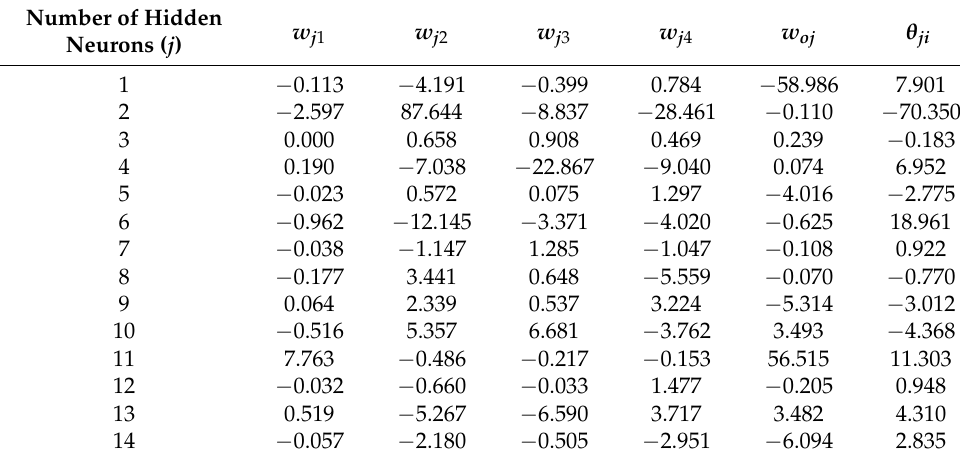
Table 9. The weight and bias values of the developed ANN-based